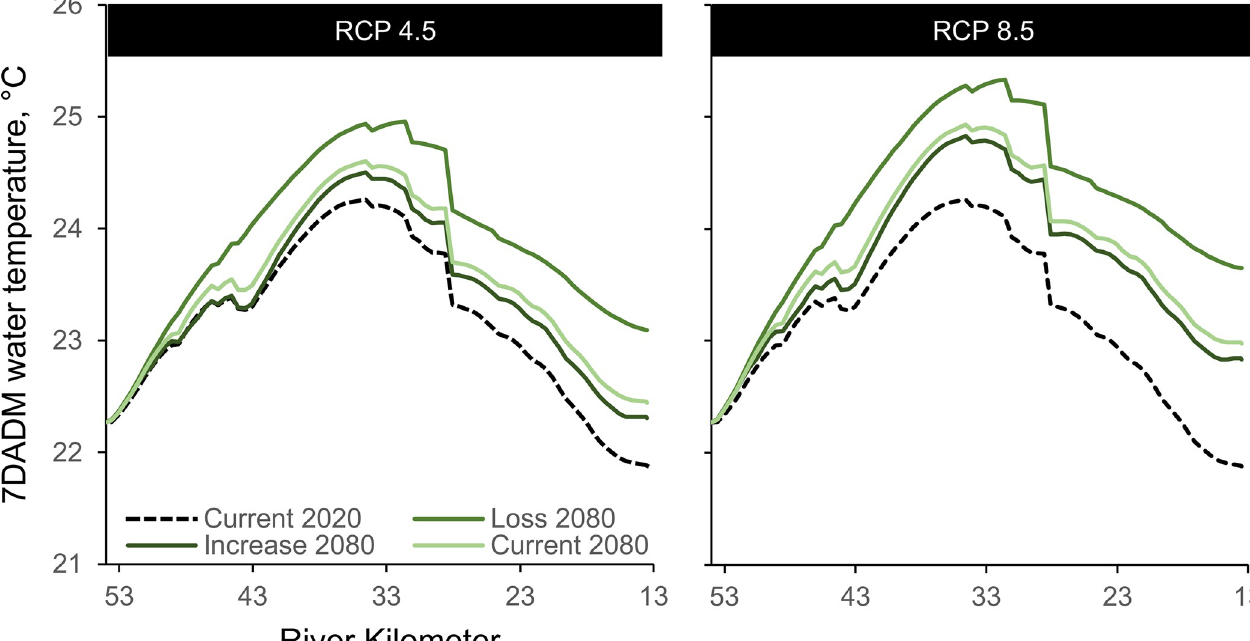
Fig 5. Maximum 7DADM water temperature. Water temperature predicted at each node under two future climate emission scenarios, RCP 4.5 and 8.5, and three riparian vegetation scenarios, as compared to current conditions.